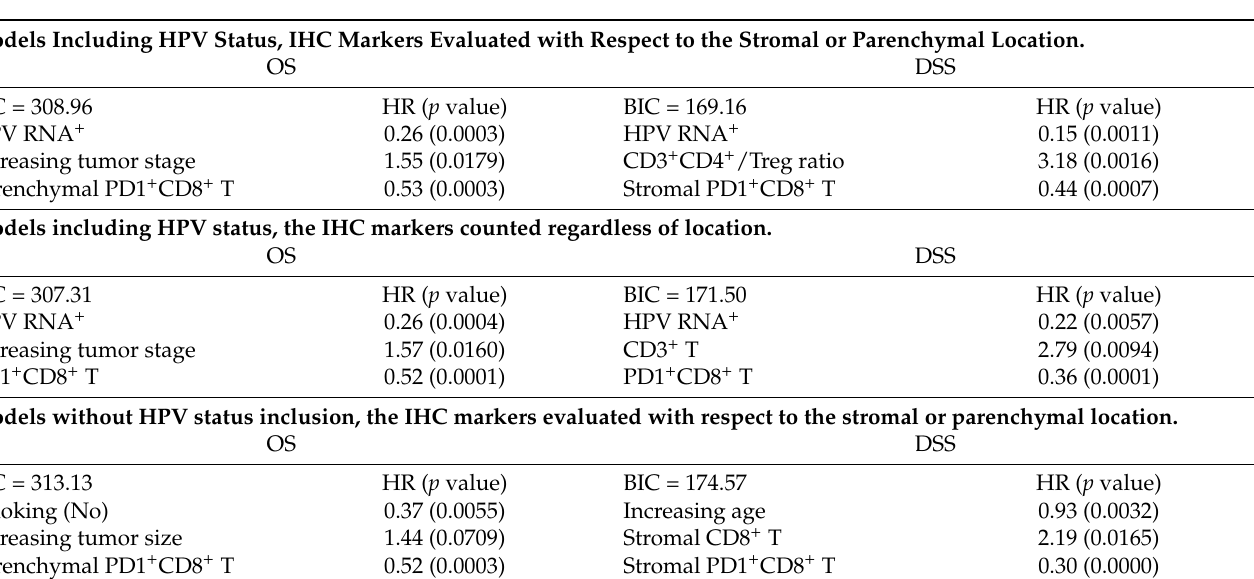
Table 4. Hazard ratio (HR) values for cell populations from the best models influencing overall survival (OS) and disease-specific survival